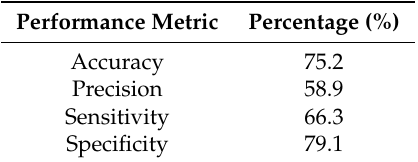
Table 3. Performance of the Hypertension Risk Prediction